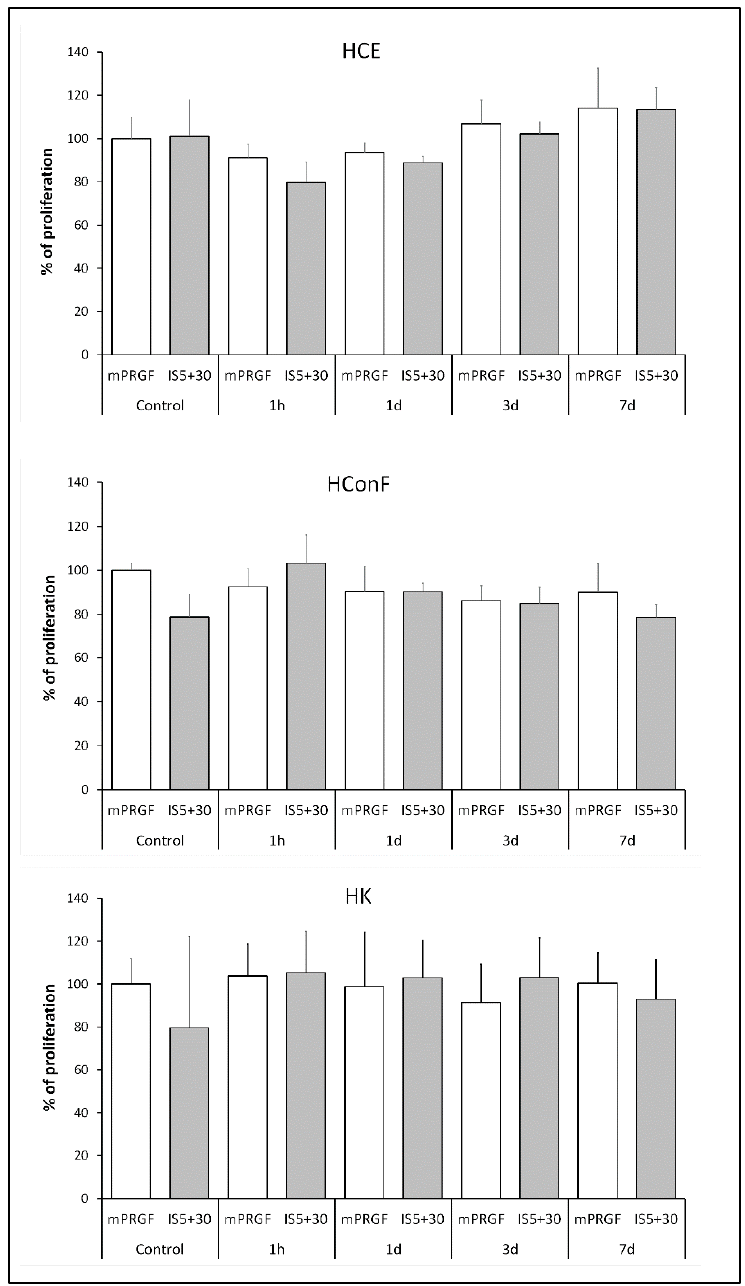
Figure 4. Proliferation percentage of different ocular surface cells (HCE, HConF, and HK) after treatment with the supernatant obtained from each of the PRGF membranes (mPRGF and IS5+30) at each time point of the kinetic release assay (1 h, and 1, 3, and 7 days) compared to the supernatant obtained after complete membrane squeezing of both PRGF membranes (control of mPRGF and IS5+30). No significant differences were observed among the different samples at any study time and in any of the cell types analyzed.